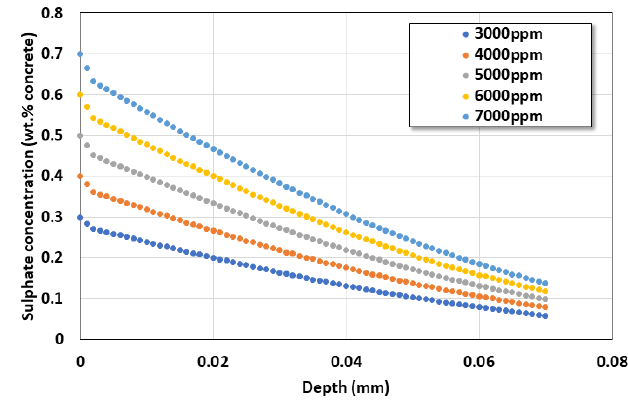
Figure 10. Sulfate ion profile after 30 years.